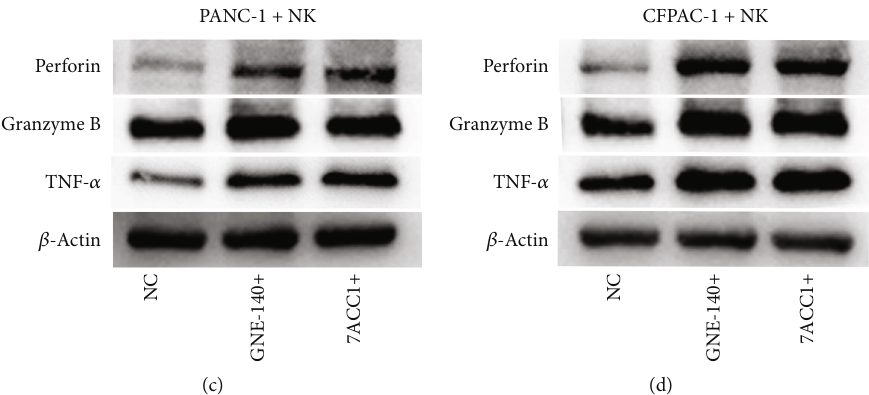
Figure 6: LDHA expression in PC cells a ff ects the function of NK cells. (a, b) The percentages of NKP46- and NKG2D-positive NK cells cocultured with PC cells treated with GNE-140 or 7ACC1. (c, d) Expression of perforin, granzyme B, and TNF- α in NK cells cocultured with PC cells treated with GNE-140 or 7ACC1 according to western blotting; β -actin served as the internal control. The data are presented as the mean ± SD from three independent experiments. ∗ P ≤ 0 : 05 , ∗∗ P ≤ 0 : 01 , and ∗∗∗ P ≤ 0 : 001